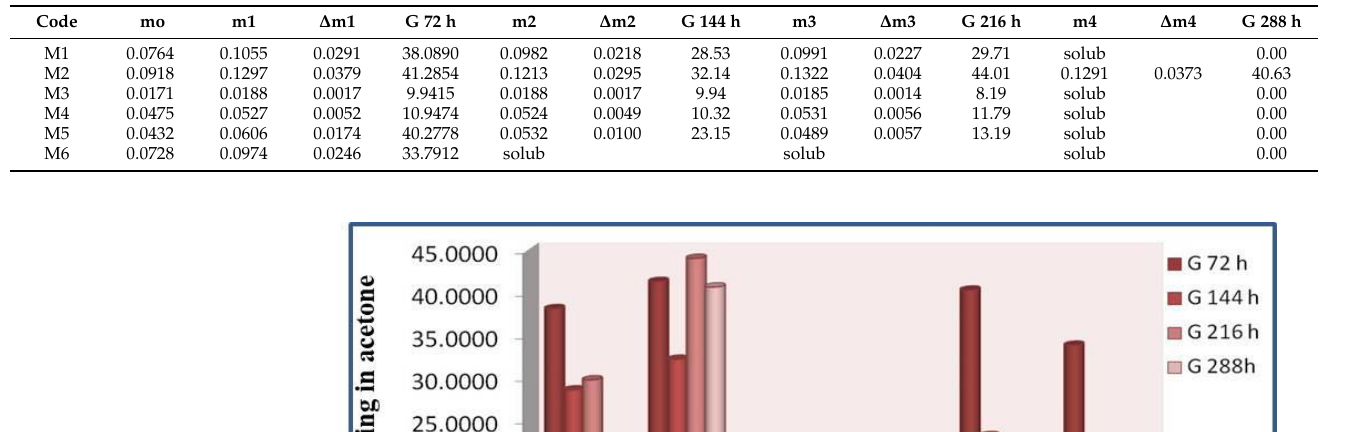
Table 3. The swelling tests in acetone for materials M1 – M6.